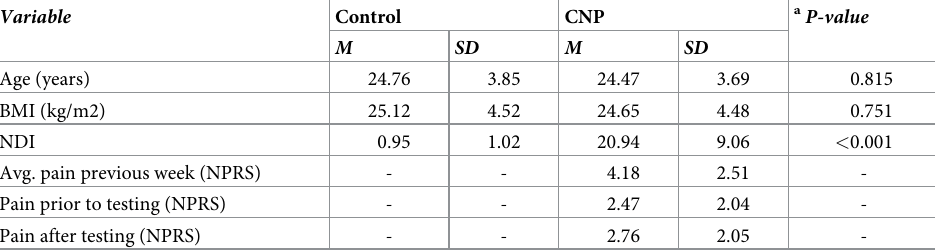
Table 2. Descriptive statistics for self-reported measures. Variable